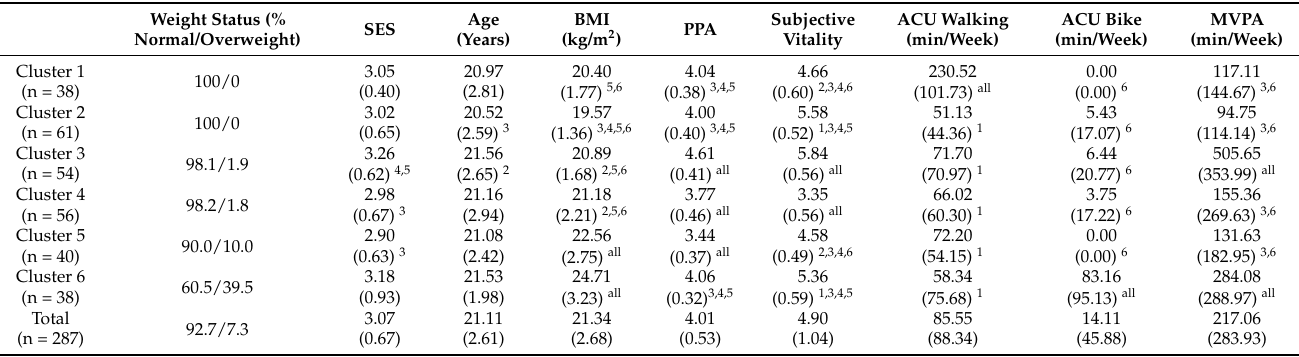
Figure 1. Neuron networks, superordinate clusters and hits obtained by the SOM analysis in the female subsample. ( A ) Neuron networks for the SOM input variables. Yellow color represents the highest values of the sample distribution for each variable, dark blue color represents the lowest values. ( B ) Quantization error according to the possible number of clusters selected. ( C ) Number of participants per cluster for the chosen cluster solution. ( D ) Hits map with the six superordinate clusters C1–C6. The more a neuron is filled with green, the higher the number of participants assigned to the neuron. BMI = body mass index, PPA = perceived physical ability, MVPA = moderate-to- vigorous physical activity, ACU = active commuting to and from university. Table 2. Pairwise comparisons between women’s